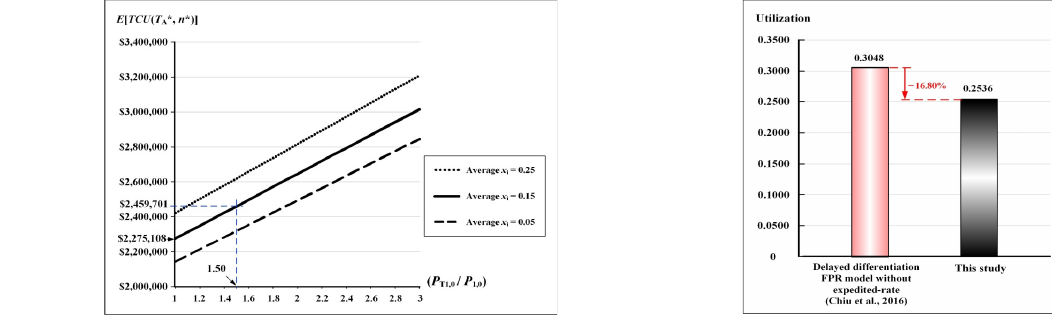
Fig. 14. Comparison of our study’s utilization with a closely related existing